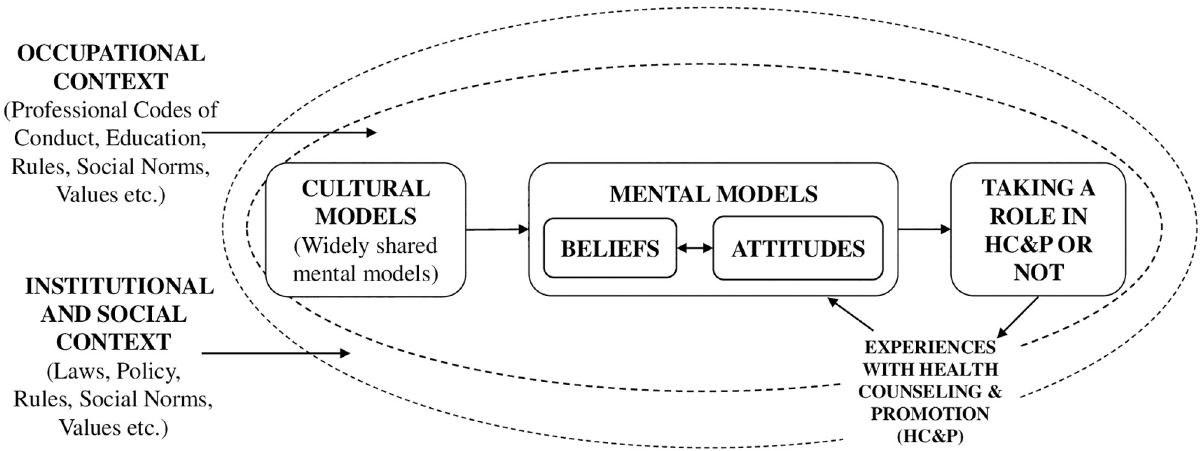
Fig 1. Theoretical framework of taking a role in Health Counseling and Promotion (HC&P) or not.